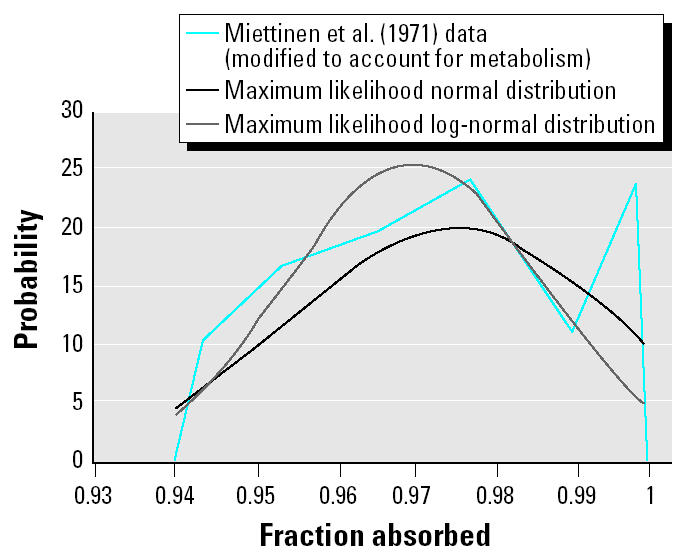
Comparison of Miettinen et al. (1971) data on the fraction of MeHg absorbed to maximum likelihood normal and log-normal distributions.